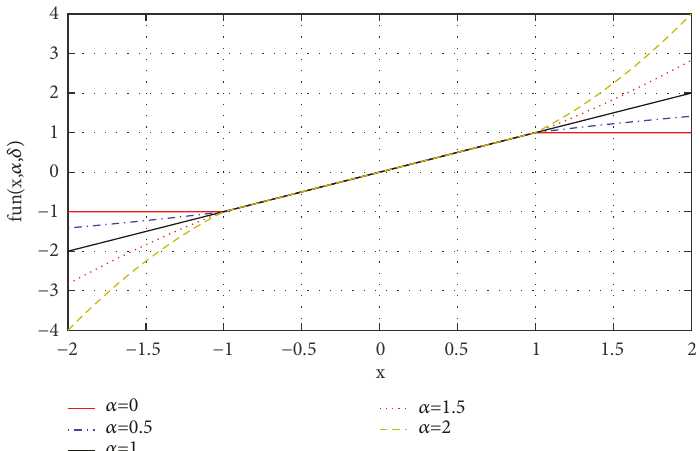
Figure 4: Graphical description of the nonlinear